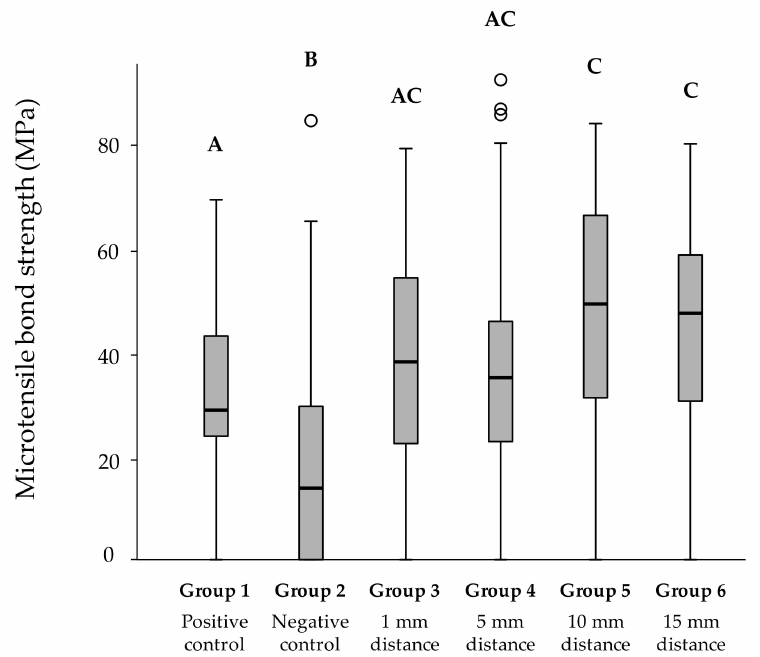
Figure 2. Microtensile repair bond strengths (MPa) of composite surfaces after sandblasting from varying working distances. Significant differences between groups are indicated by different letters ( p < 0.05). Within each boxplot, the median is represented by a horizontal bold black line. The 25% and 75% data quartiles are shown as boxes, and the whiskers mark the 1.5 × interquartile range (IQR) at the 25th and 75th percentile of each group. The outliers of groups 2 and 4 are shown as circles.